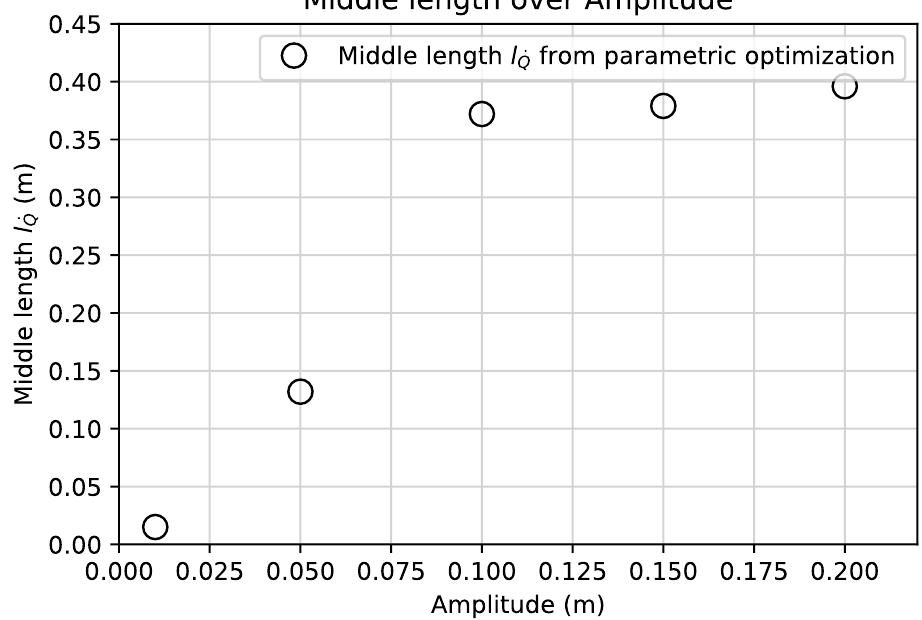
Figure 12. Resulting l ˙ Q from the optimization over the amplitude A .